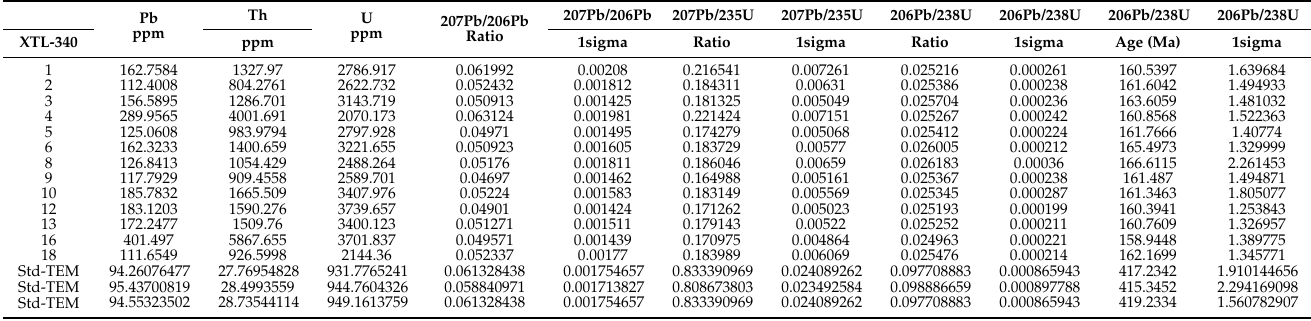
Table 8. LA-ICPMS U–Pb zircon dating data of the XTL340 from the Xintianling